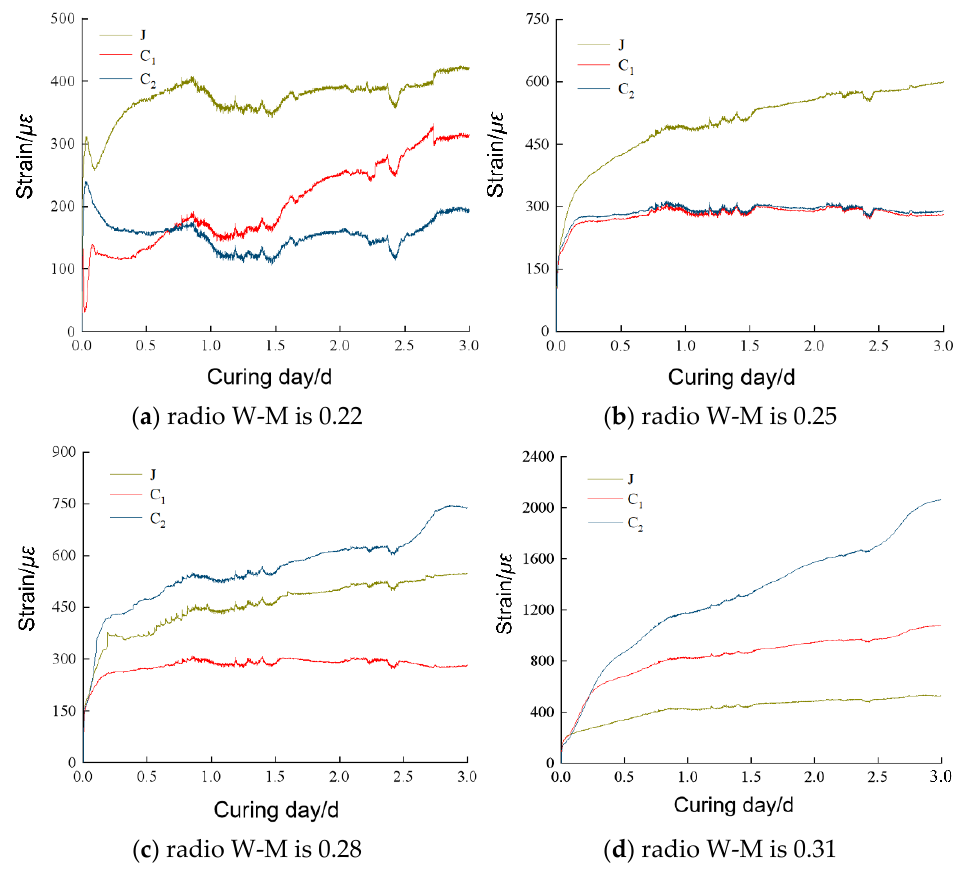
Figure 10. In-hole solidification strain at different water-to-material ratios.